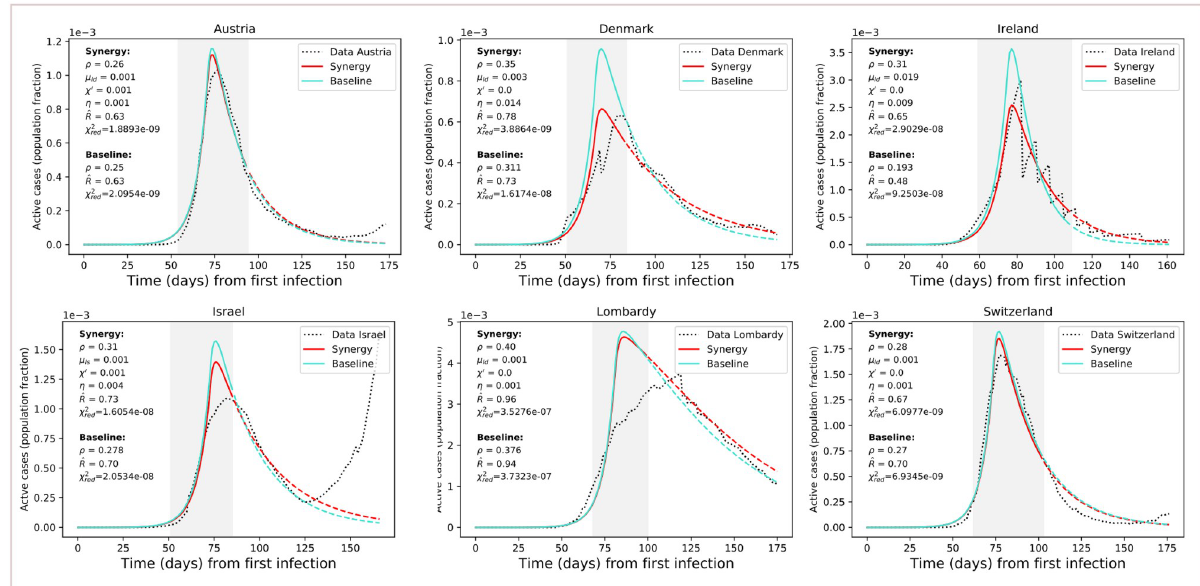
Fig 9. Results of model fitting. Results of model fitting. Infection curves for the considered countries (dotted) are fitted with the SPQEIR model with appropriate parameters (red curves). We also show a comparison with the fitted curve obtained from the “basic” SEIR model with only social distancing (turquoise curves). Parameter values are reported for each country, as well as the corresponding ^ R (for the grey area, following Eq 1) and w 2 period of measures enforcement, from t to t , is highlighted by the grey region. Time progresses from the estimated day of first infection t 0 (cf. m p Table 3). Population fraction refers to country-specific populations (cf. Table 1). After phase-out, we prolong the fitted curve (parameter values unchanged) to compare observed data with what could have been if measures had not been lifted (dashed lines). From the data, we can observe a resurgence of cases that points to possible “second outbreaks” (particularly in Israel).